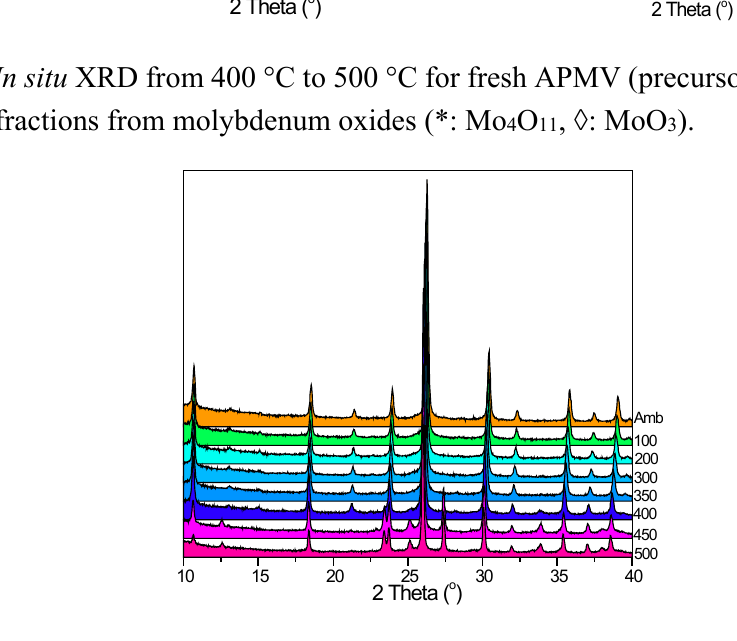
Figure 5. In situ XRD in air for the supported sample